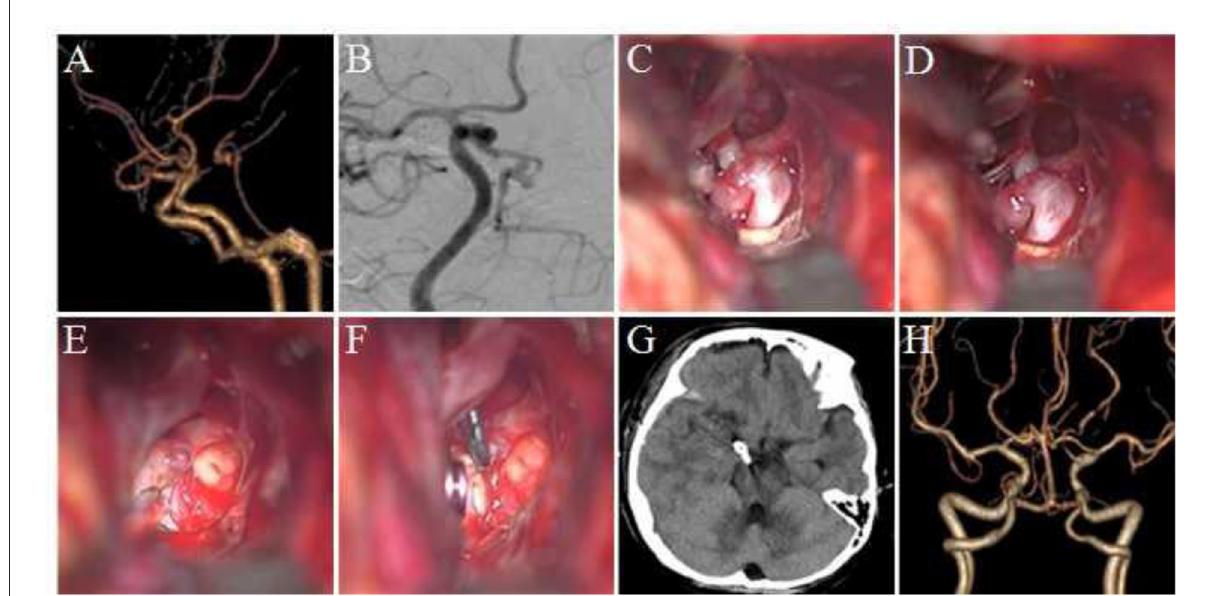
FIGURE3 Clipping multiple aneurysms at the P1–P2 bifurcation of posterior cerebral aneurysm via the Dolenc approach. (A) Preoperative CTA revealed an aneurysm at the left posterior cerebral P1–P2 bifurcation with irregular shape and basilar artery and bilateral posterior cerebral artery stenosis. (B) DSA revealed two aneurysms at the bifurcation of P1–P2 of the posterior cerebral artery, exhibiting a lobulated shape. (C) During surgery, the P1–P2 bifurcation aneurysm could be seen in the lateral space of the internal carotid artery, which points to the posterior and medial side,